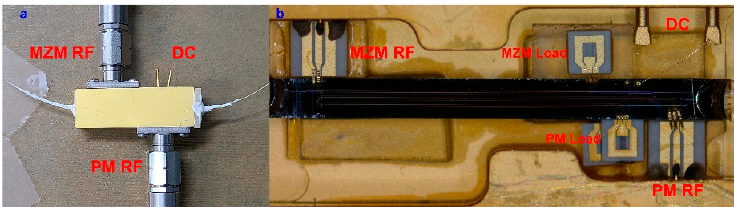
Figure 2. Photographs of the packaged LNOI modulation device. ( a ) Exterior appearance. ( b ) Internal layout.